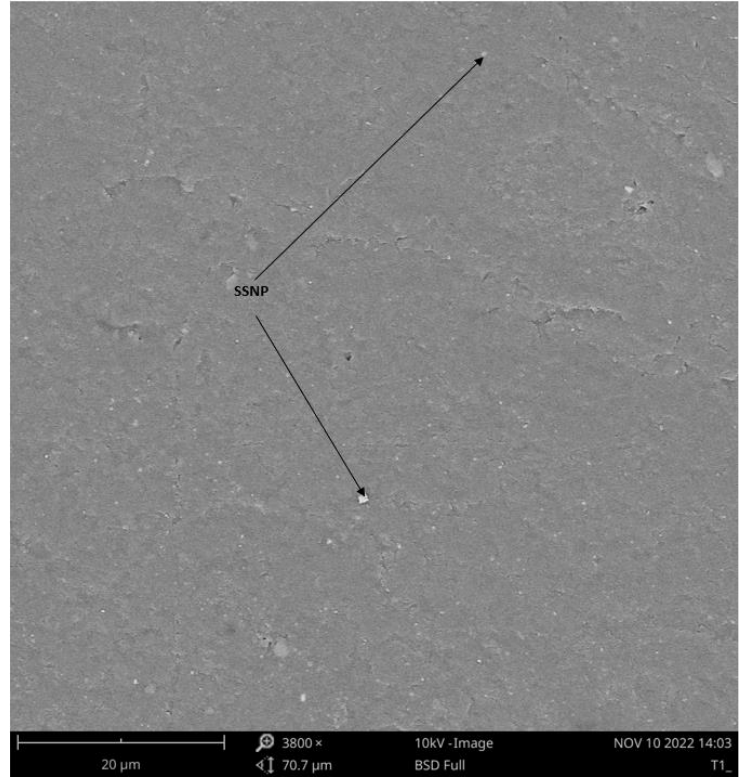
Figure 6. SEM image of the developed bioplastic film.